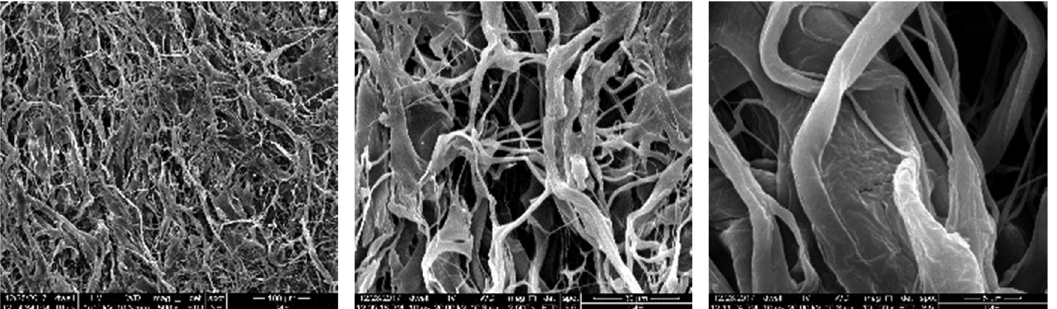
Figure 2: Samples of the outer surface collagen membrane at di ff erent magni fi cations ( from left to right: 500 × , 2,500 × , and 10,000 ×) . A tightly woven and fi brous morphology is observed. At high magni fi cation, one sees the typical periodic pattern of collagen fi